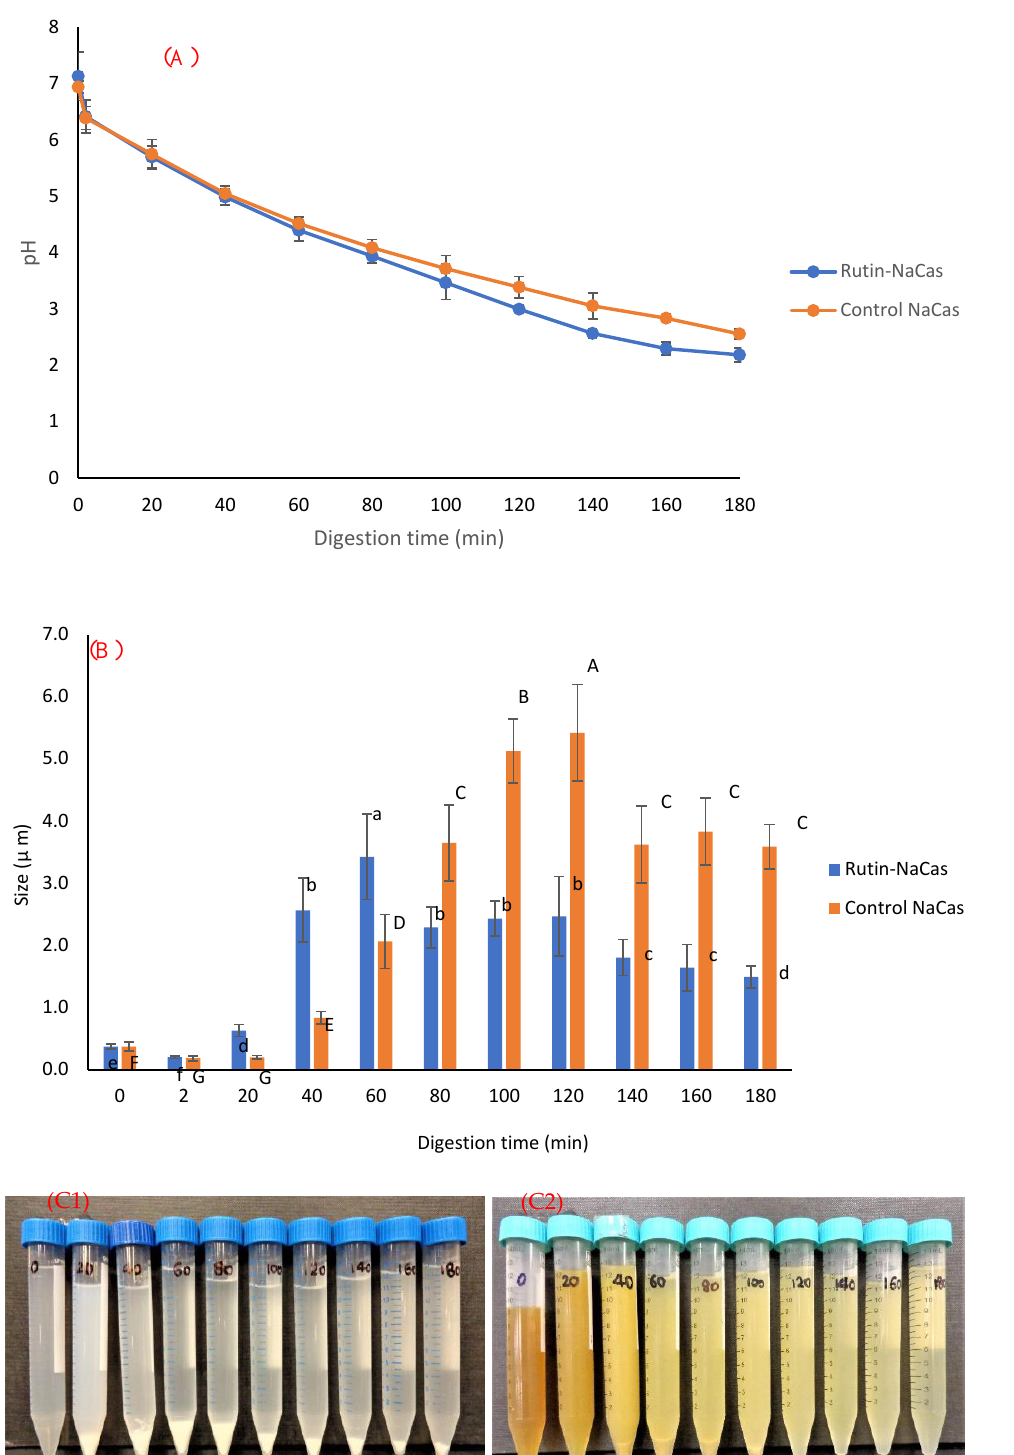
Figure 5. The behaviour of control NaCas and rutin – NaCas nanocomplexes (NaCas:rutin ratio of 2.5 w/w ) throughout the simulated gastric digestion. ( A ) pH profile; ( B ) particle size; ( C ) appearance (C1: control NaCas, C2: rutin – NaCas). Columns of the same colour containing different letters are significantly different at p < 0.05.